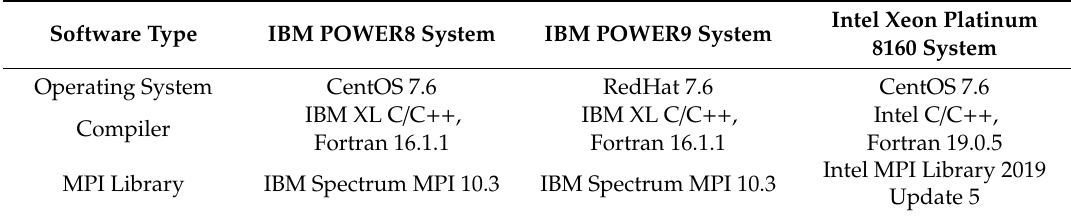
Table 2. Computing systems’ software.